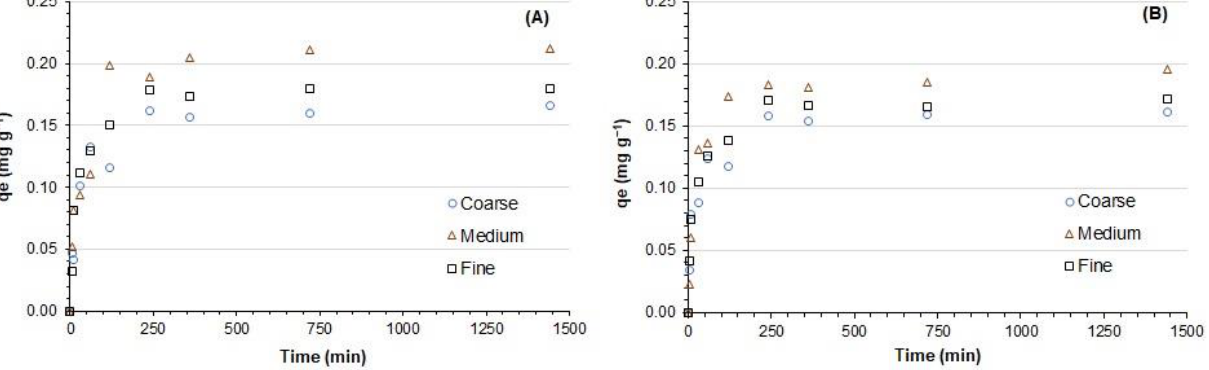
Figure 6. Adsorption kinetic profiles of phosphate ions on adsorbent substrates prepared with the three granulometric fractions of material and activated with HCl ( A ) and H 2 SO 4 ( B ).